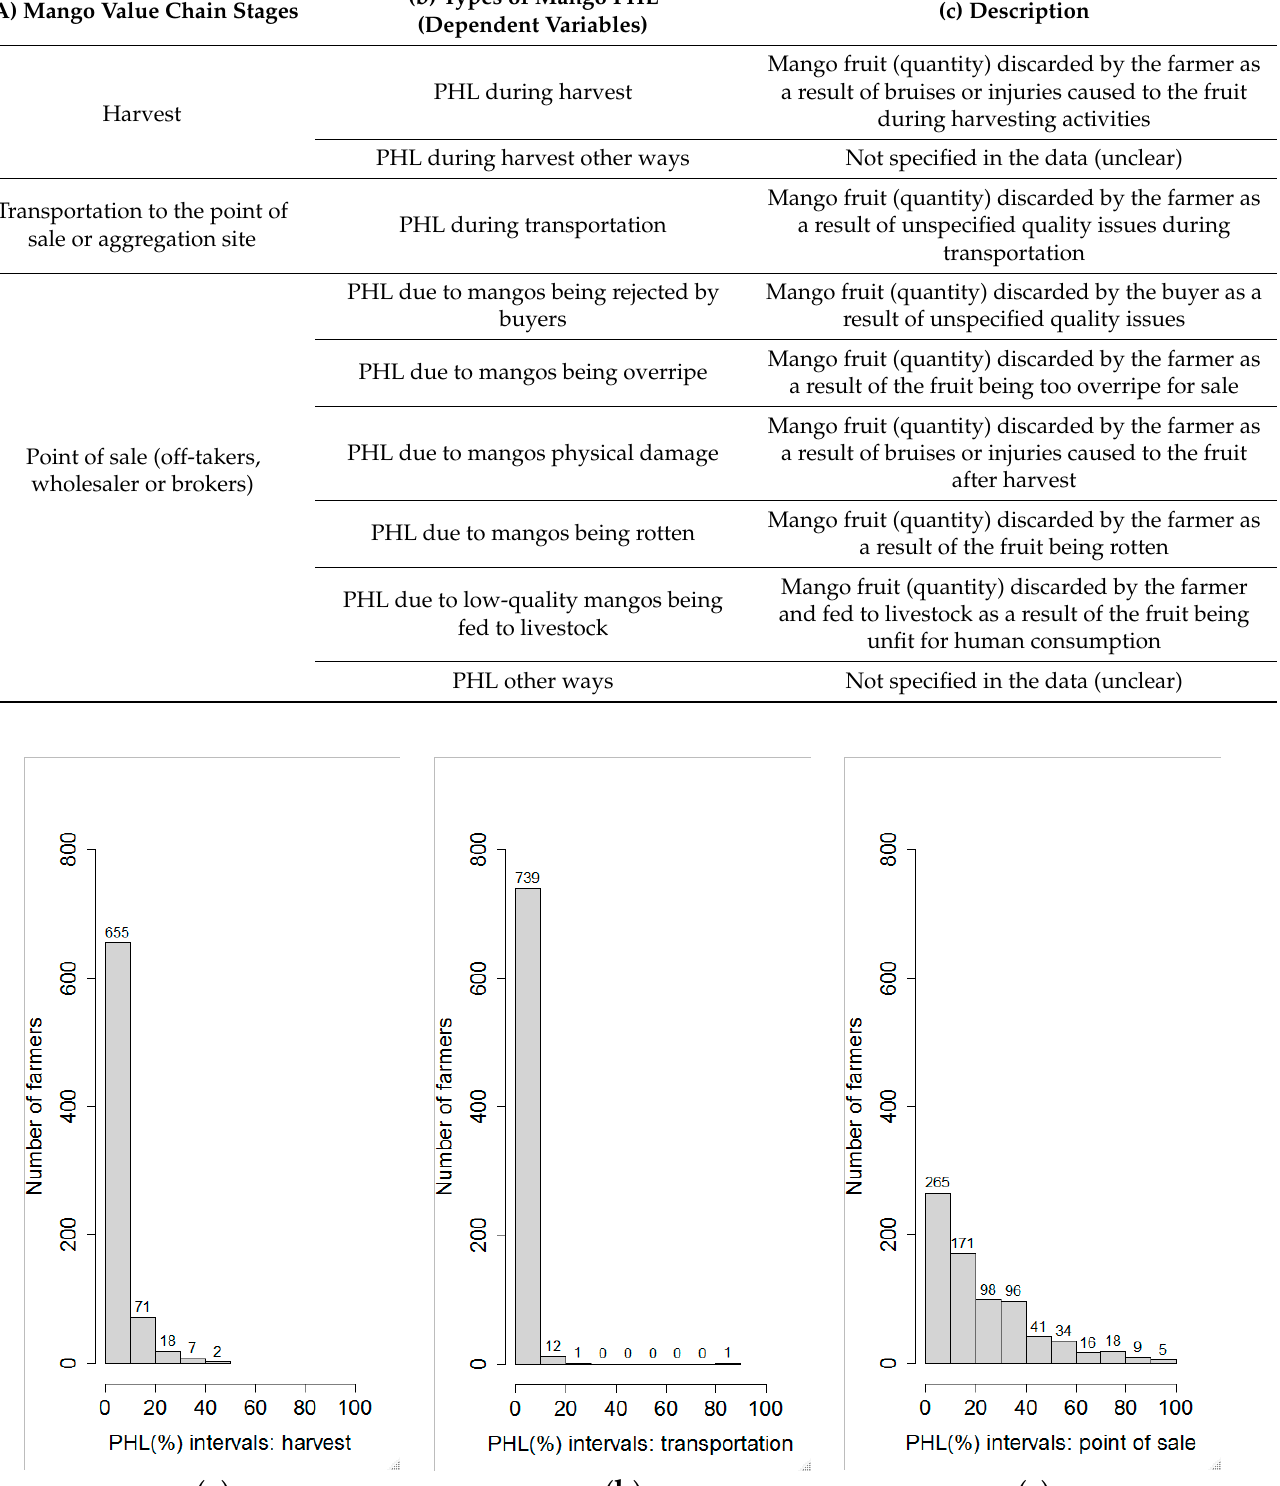
Table 4. Summary of all factors, subsets of factors, respondent farmers, and the seven types of mango PHL: Column ( a ) lists all 21 factors including the 19 categorical C , two numerical N , and four containing postharvest technologies T . Column ( b ) expands each factor into subsets that were previously referred to as subset descriptors in Table 1. The superscript YWI is used to identify technologies promoted by the YWI. “Other” refers to the combination of multiple subsets as reported by respondent farmers. Column ( c ) indicates the number of respondent farmers belonging to each subset. Column ( d ) encompasses mango PHL at harvest, during transportation, at point of sale, and as a total of all three value chain stages. PHL averages cannot be categorized by numerical factors, hence the n/a notation. (a) Factors